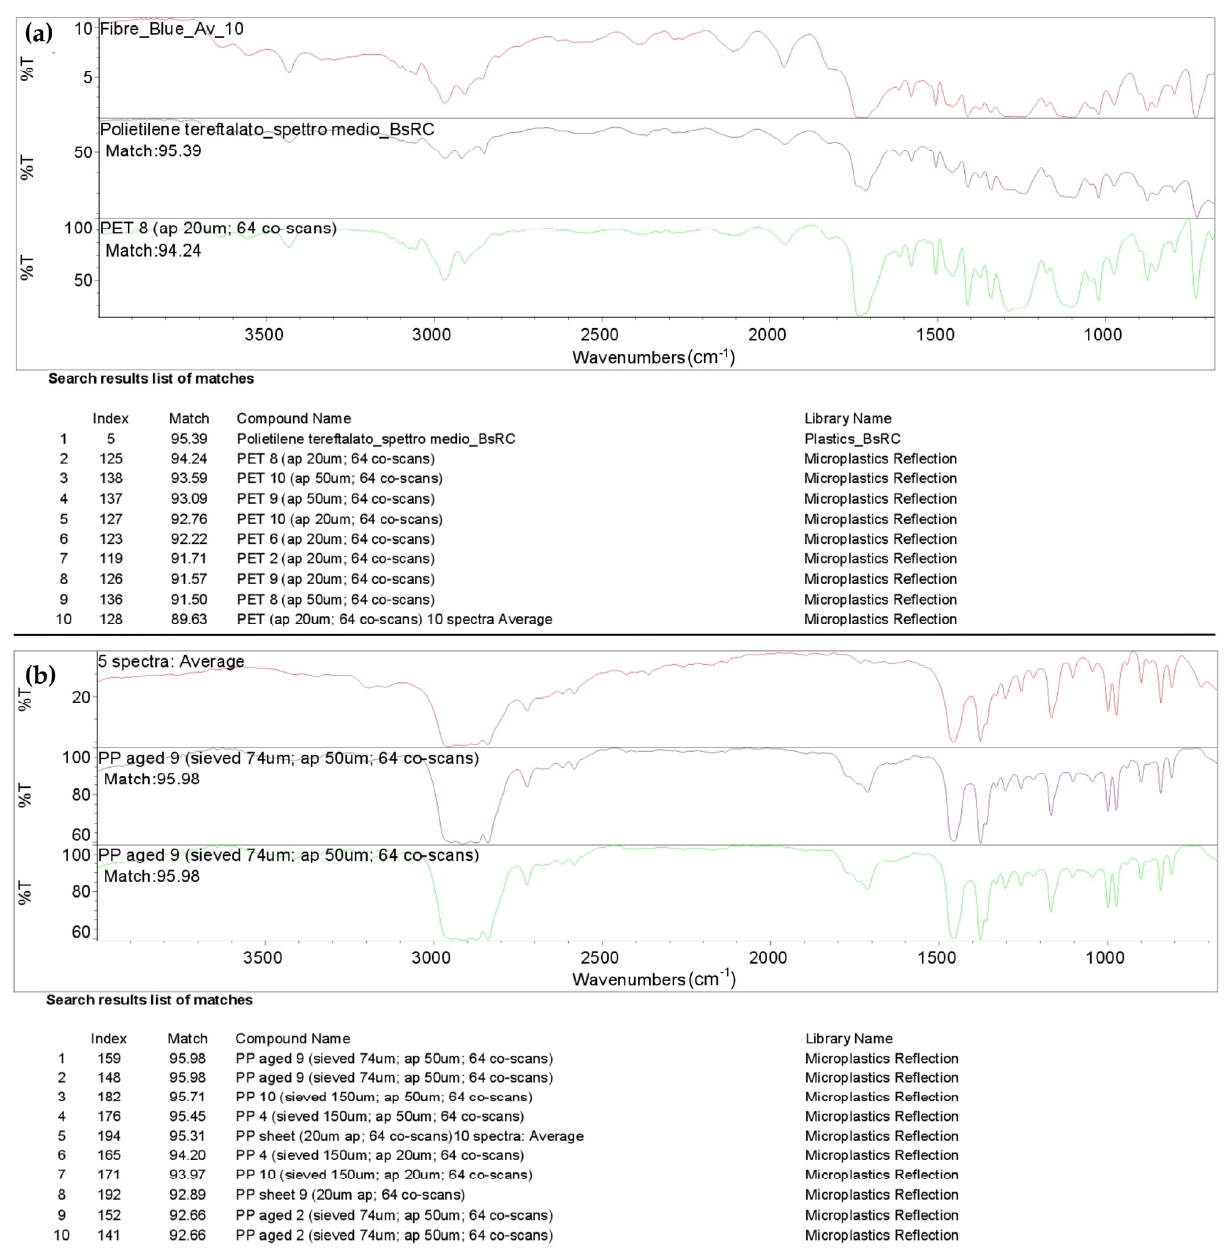
Figure 2. Average spectrum of a PET (polyethylene terephthalate) ( a ) and PP (polypropylene); ( b ) microparticle found in the samples analyzed (red lines) and the spectral match with the reference library (other